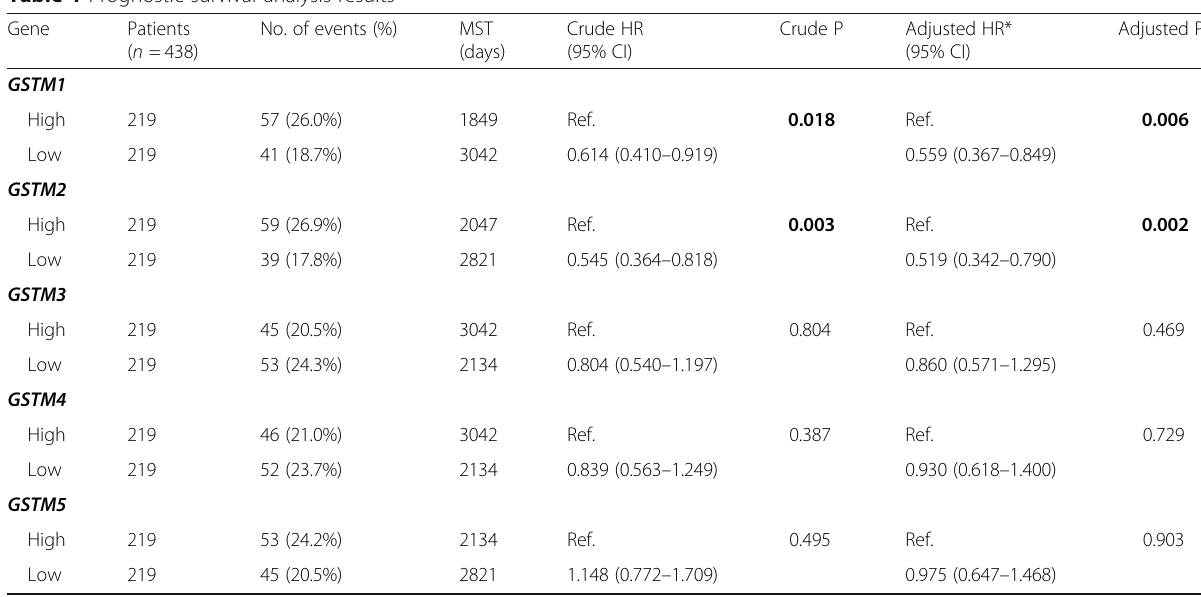
Table 1 Prognostic survival analysis